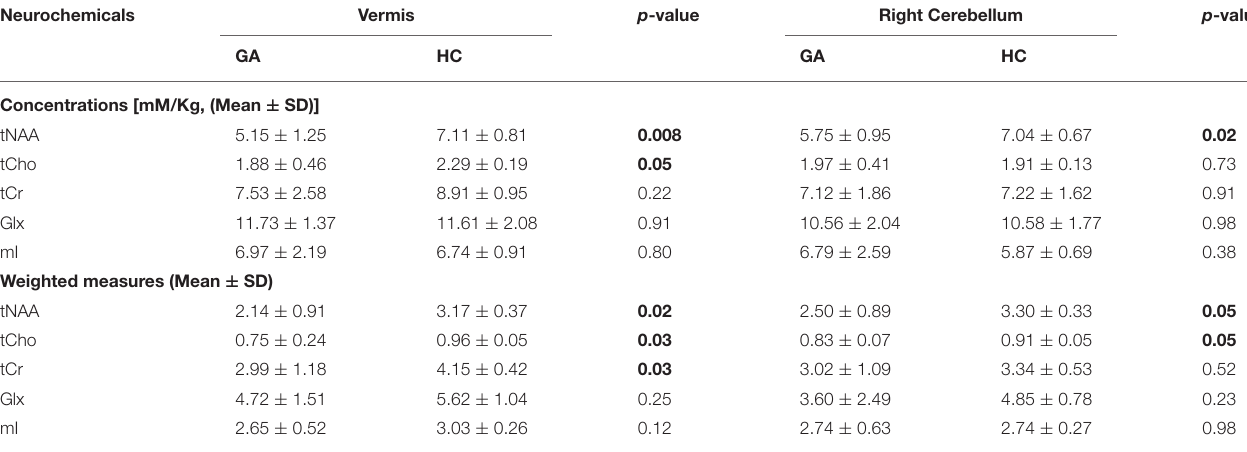
TABLE 4 | Comparison of the concentrations of neurochemicals (corrected for CSF) and their weighted measures in the vermis and right cerebellum of patients with Gluten Ataxia (GA) ( n = 6) and Healthy Controls (HC) ( n = 10). Neurochemicals Vermis p -value Right Cerebellum p -value GA